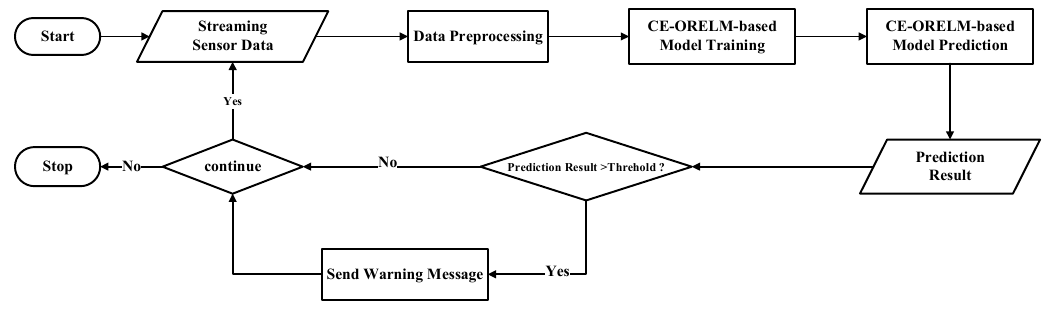
Figure 4. Framework of the prediction model.